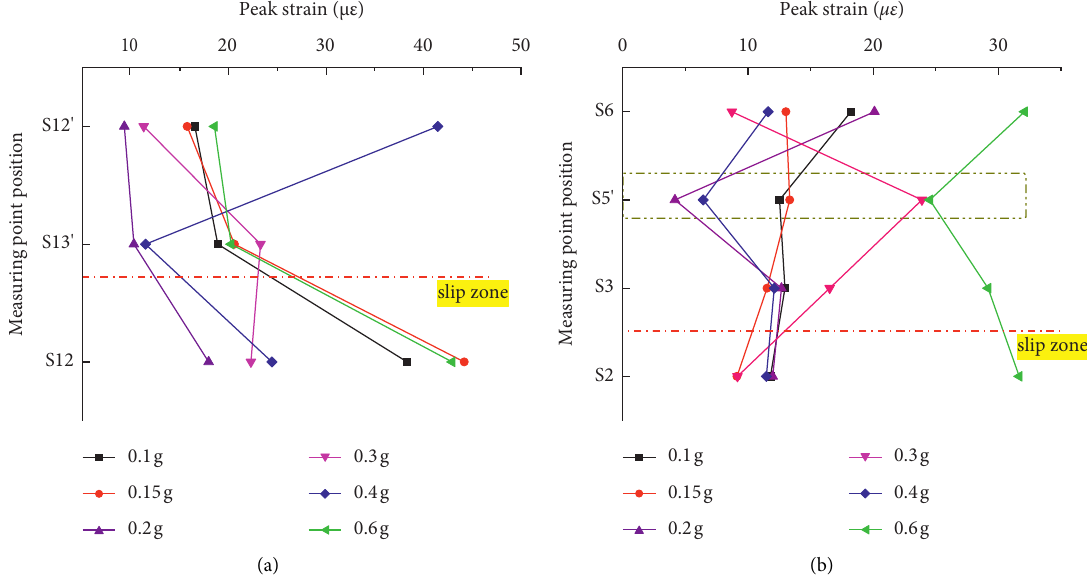
Figure 14: Peak strain at measuring points of bridge pile under different working conditions. (a) Pier column on the side of the mountain. (b) Pier column on the